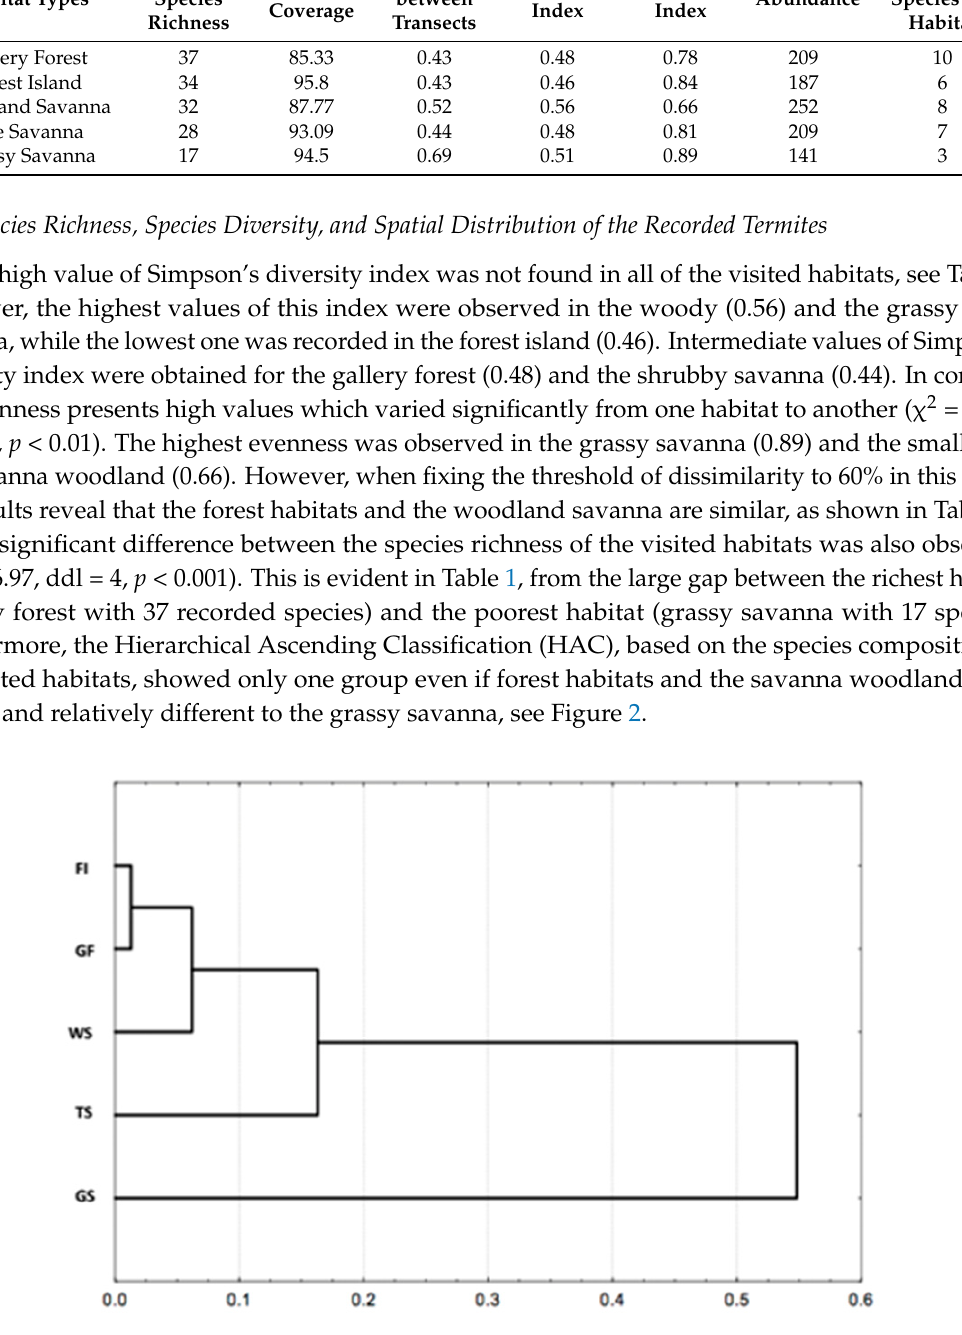
Table 1. Metrics of termite diversity in the different habitats.